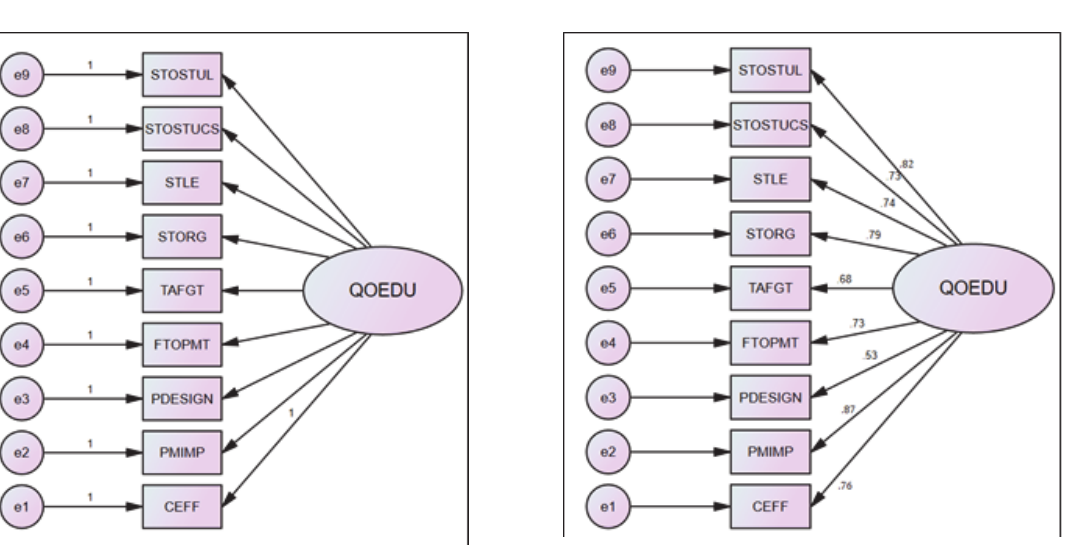
Fig. 1. CFA for explanatory variables Fig. 2. Factor Loadings for explanatory variables